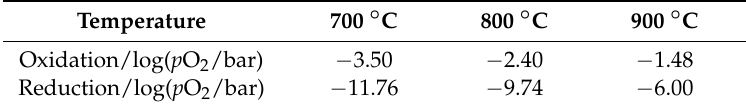
Table 2. Stability limit of CuFeO 2 for three characteristic temperatures, corresponding to the Ellingham diagram shown in Figure 4. The upper (oxidization) and lower (reduction) limits are listed. Temperature 700 ◦ C 800 ◦